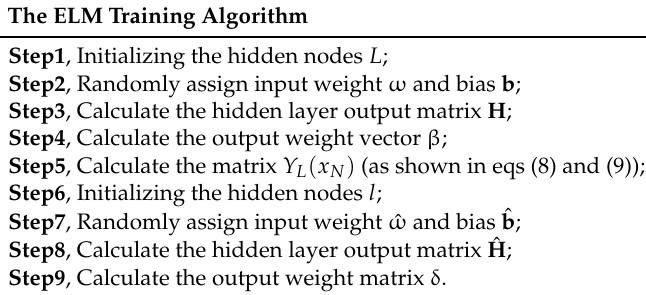
Table 1. The ELM training